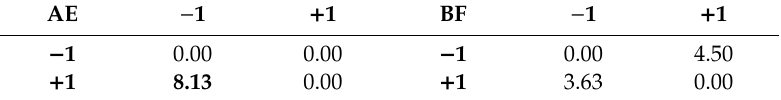
Table 9. Analysis of the e ff ects of interactions AE and BF on the retained austenite.